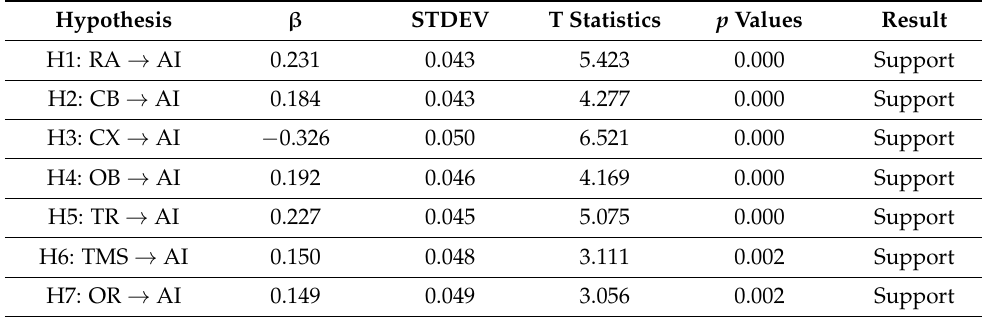
Table 4. Assessment of the structural